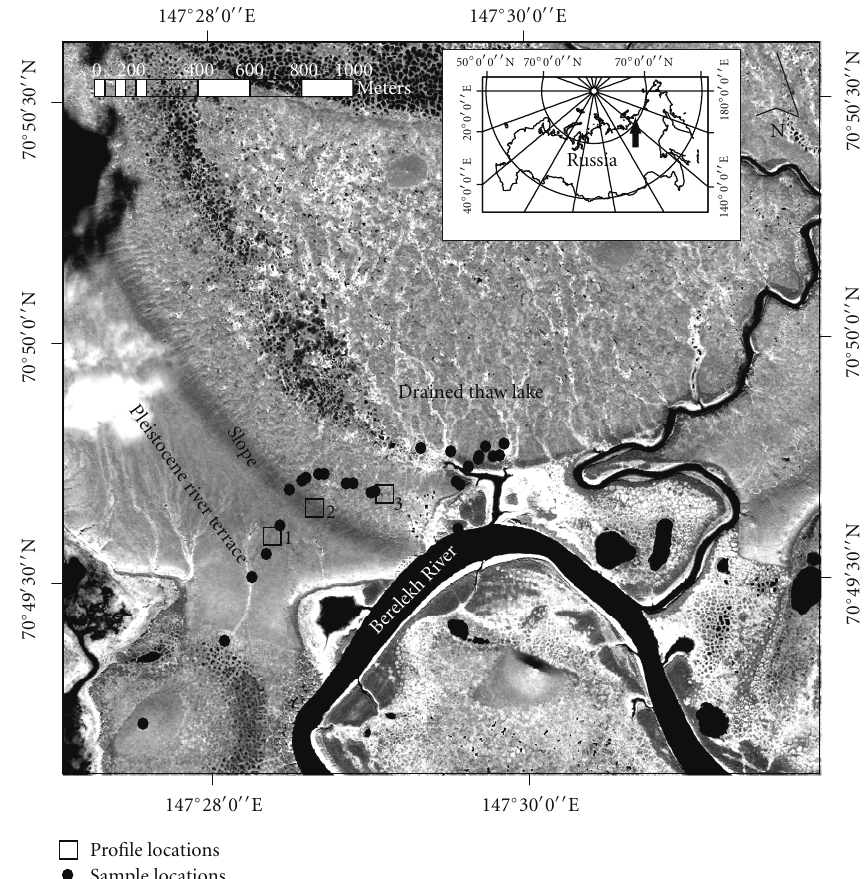
Figure 1: Panchromatic GeoEye-1 image with an overview of the study area including the locations of the profile descriptions and sample locations. The arrow on the overview map indicates the location of the study area in